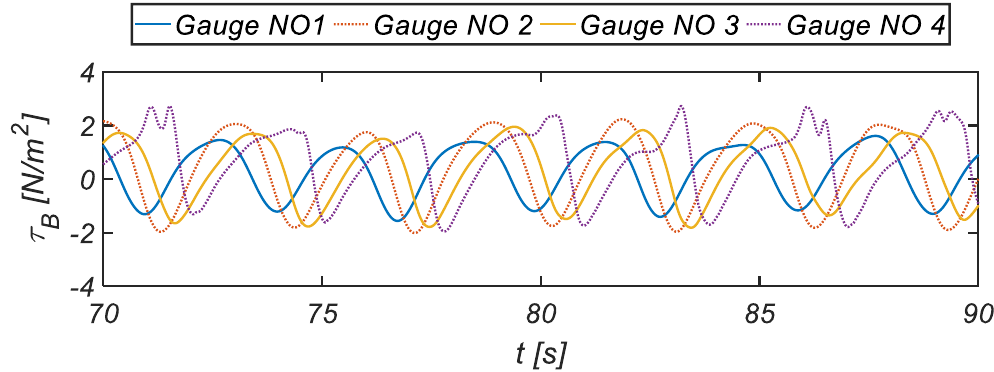
Figure 12. Temporal variation of the bottom shearing stress at Gauge NO. 1, 2, 3, and 4 [Run 2].